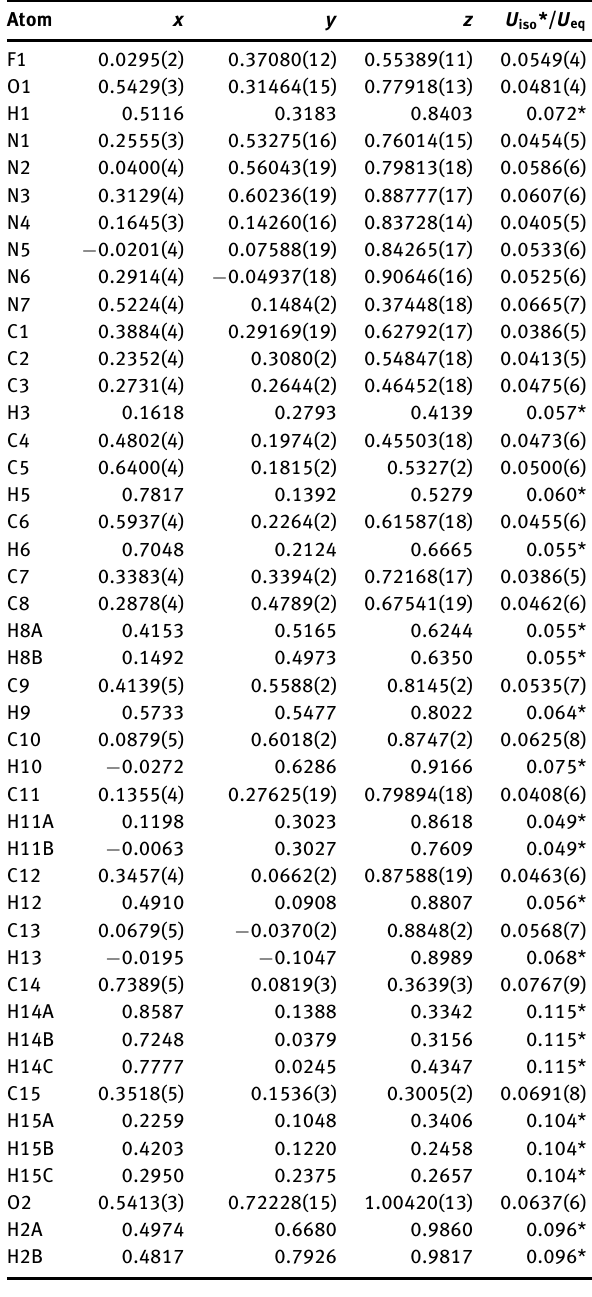
Table 2: Fractional atomic coordinates and isotropic or equivalent isotropic displacement parameters (Å 2